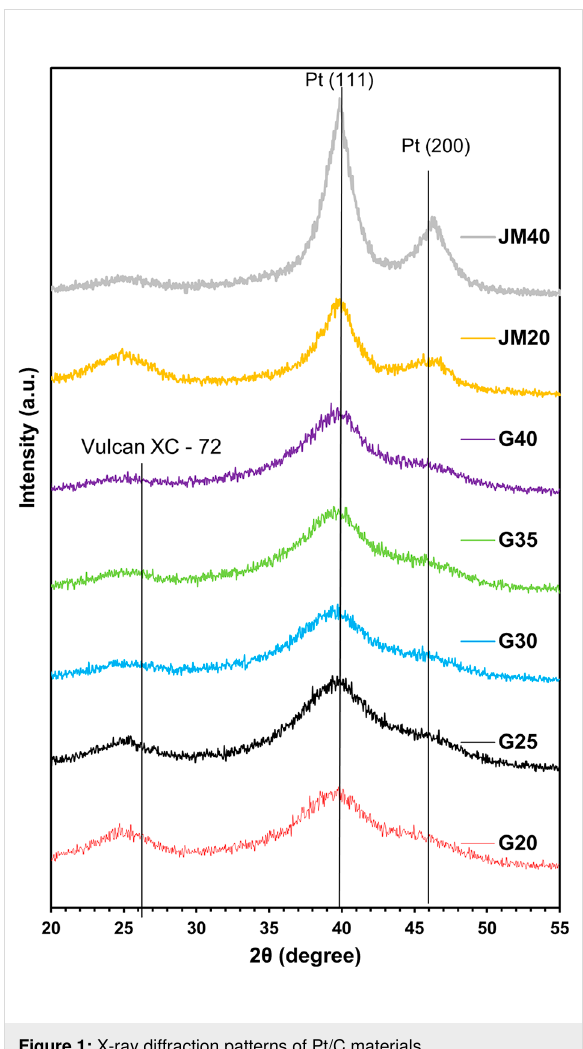
Figure 1: X-ray diffraction patterns of Pt/C materials.